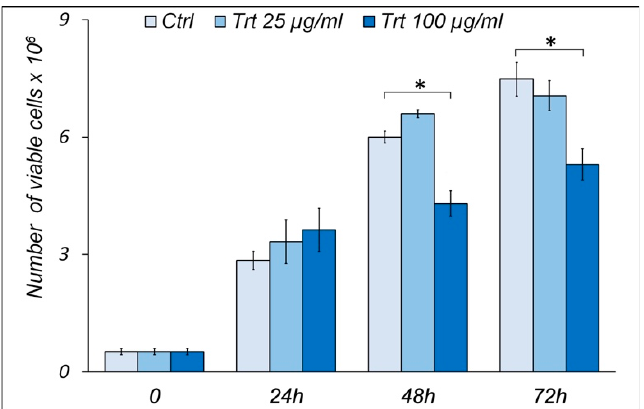
Figure 1. Effect of rubber powder on viability and cell growth. Histograms show number of viable RAW cells, treated (Trt) or untreated (Ctrl) for 24, 48, and 72 h with 25 or 100 μ g/mL of passenger tire wear particles, evaluated by exclusion Trypan blue method. On the other hand, at 100 μ g/mL, there is a reduction in cell proliferation both at 48 and at 72 h. No significant changes have been observed previously. Under all conditions, cells appear viable. Means ± S.E.M. are reported (n = 3). Student’s t test was employed to compare the values of untreated (control) and treated cells. * p < 0.05.